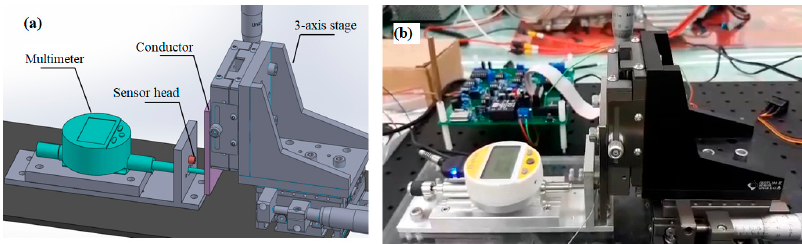
Figure 8. Experimental setup: ( a ) schematic illustration, and ( b ) photograph.